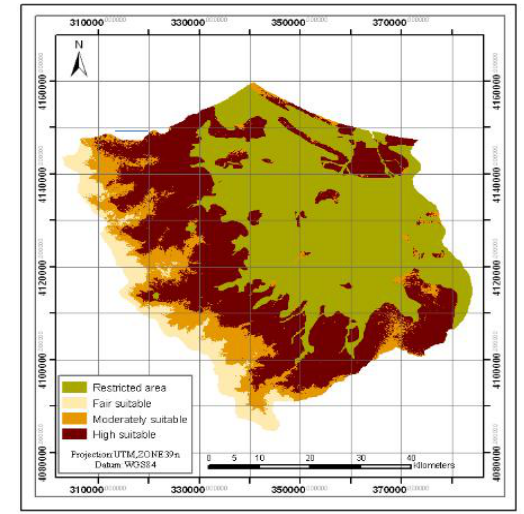
Figure 3 : Land suitability for ecotourism development in Anzali Watershed copyright from Bali et al. (2015)